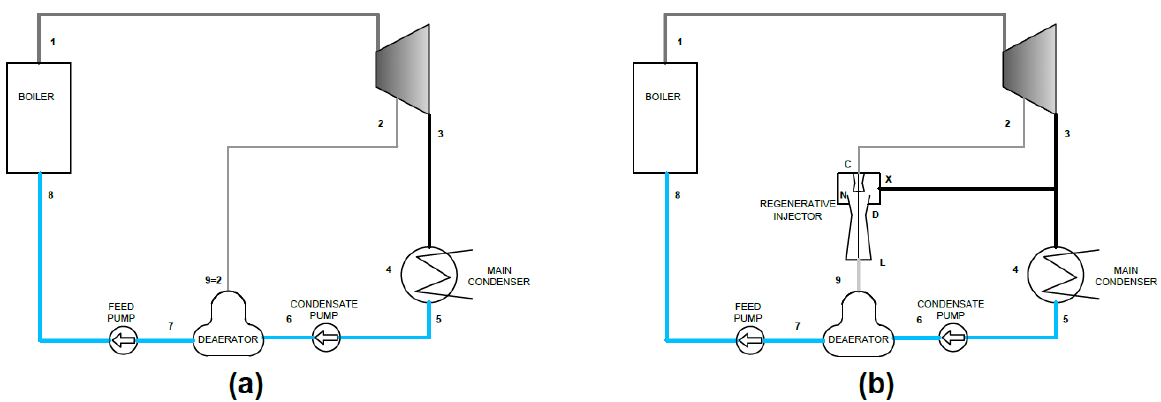
Figure 1. Thermal flow diagram of the proposed model: ( a ) Clausius–Rankine cycle with a regenerative heater (deaerator) feed from steam bleed; ( b ) Clausius–Rankine cycle with a regenerative heater (deaerator) feed by regenerative injector. Reproduced with permission from the MAPE Conference Organizing Team, published by New Trends in Production Engineering 2018.